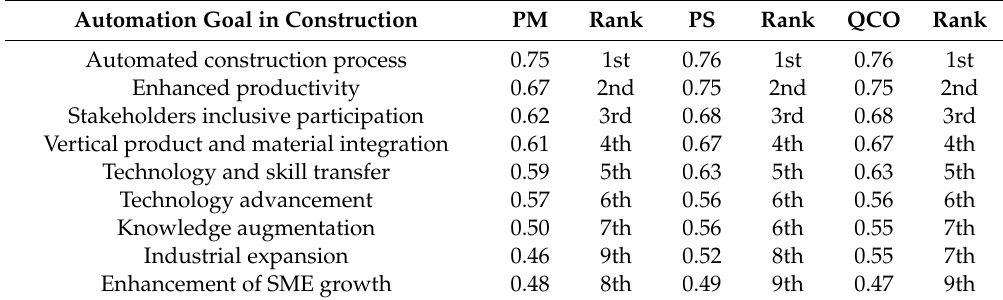
Table 15. Future of Construction 4.0 in achieving automation goal in construction. Automation Goal in